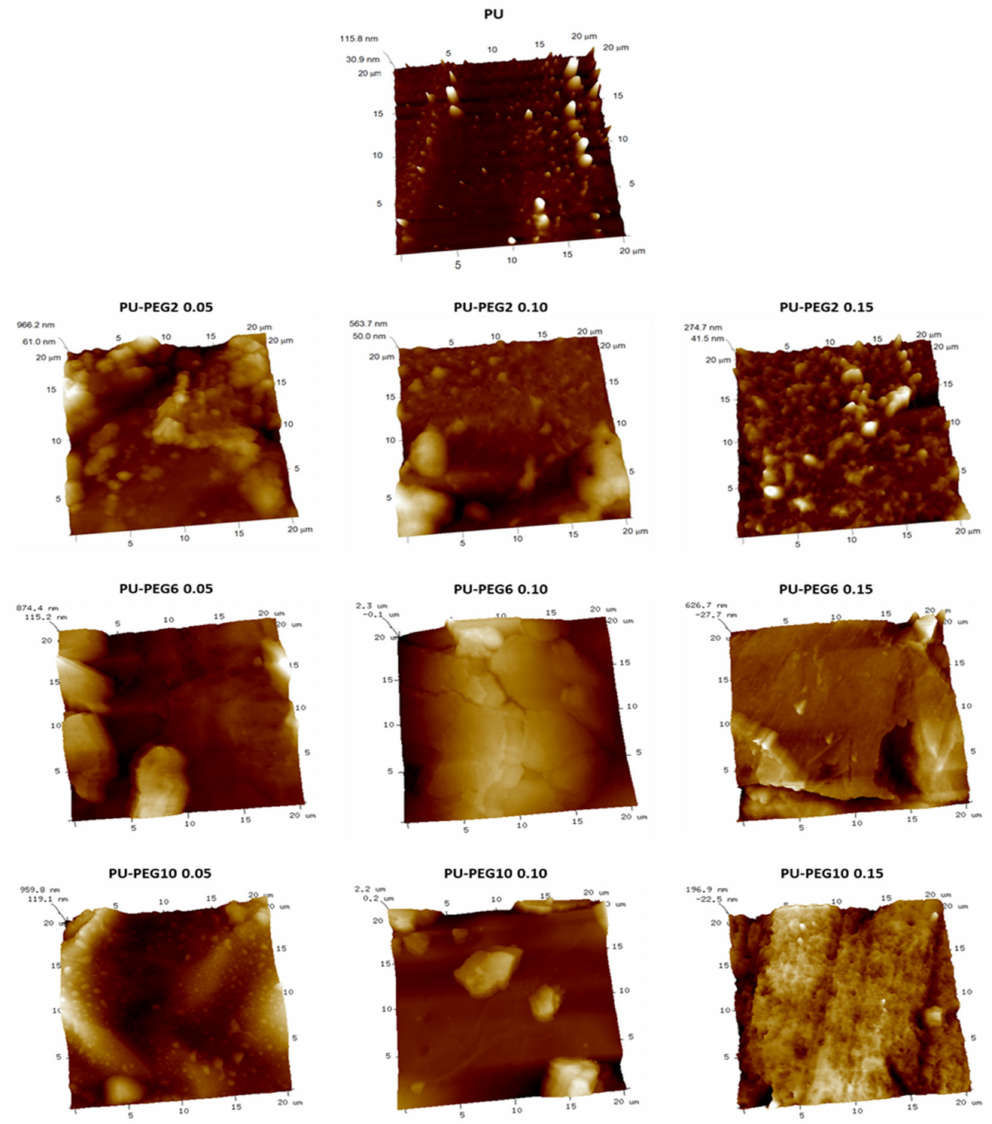
Figure 4. AFM images of the unmodified and grafted PU substrata.